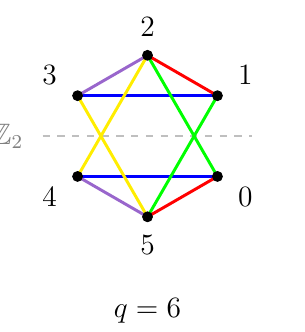
Figure 5. A partial coloring for q = 6 which illustrates what goes wrong when one demands too much symmetry. Here we propose Z 2 symmetry, which according to our general result is too much. On the left we show a partial coloring with Z 2 symmetry. On the right, we show the same coloring modded out by the Z 2 symmetry. The dots on the right are vertex orbits, and the double lines of each color are edge orbits. The problem is that we need two edge orbits between each pair of vertex orbits, and all of them (in this simple case) must have di(cid:11)erent colors. That means we need six colors just for the external edges, and we only have (cid:12)ve to work with | leaving us without a second color to use in connecting the 01 and 34 orbits. Internal edges would run within a vertex orbit, for example from 0 to 1.